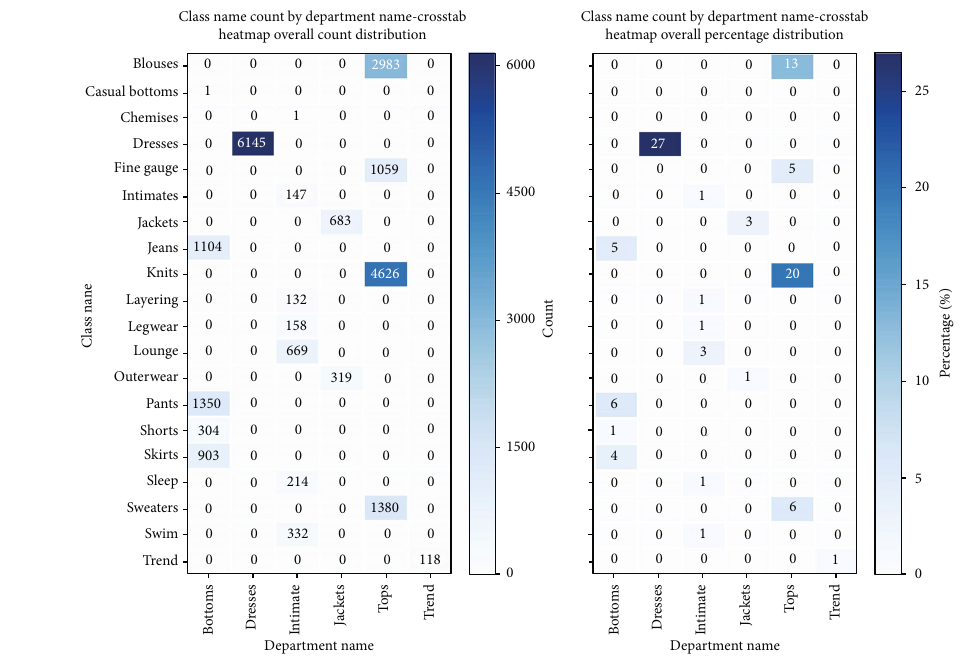
Figure 9: The domination of dress between clothe